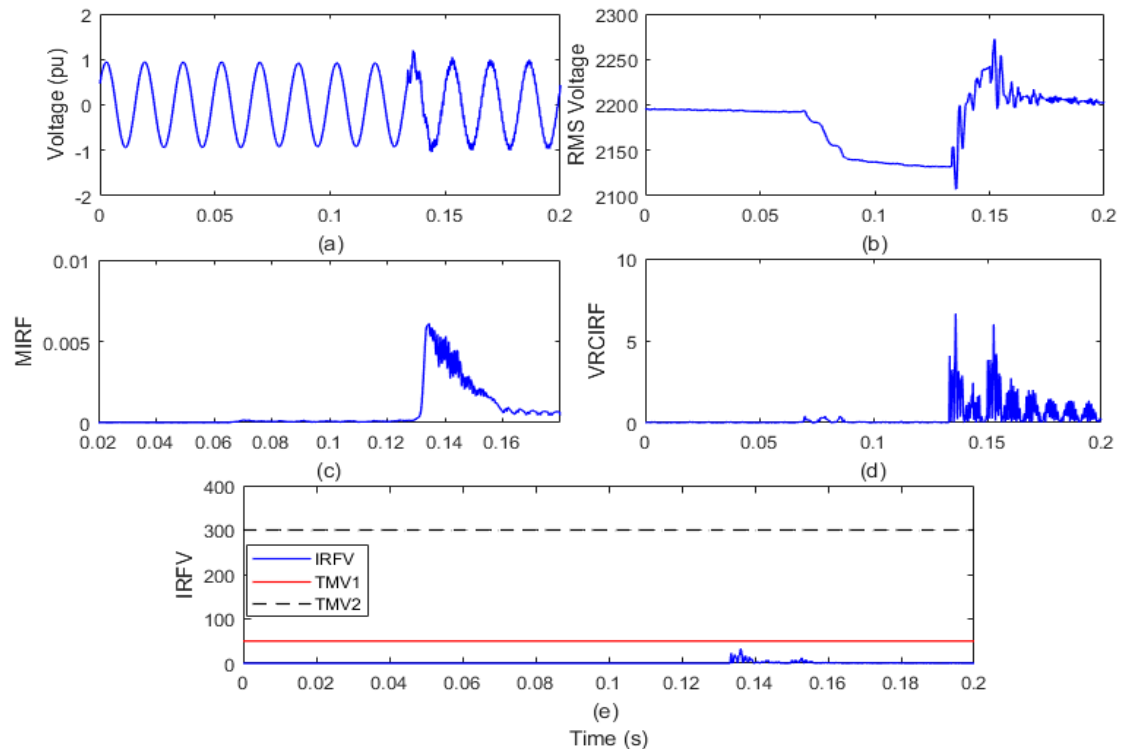
Figure 16. Capacitor switching ( a ) voltage signal ( b ) root means square value of voltage ( c ) median-based IRF ( d ) rate of change in voltage-based IRF ( e ) islanding recognition factor based on voltage.